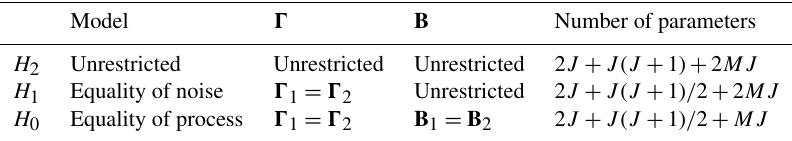
Table 1. Table summarizing the hypotheses considered in the hierarchical test procedure. Model (cid:48) B Number of